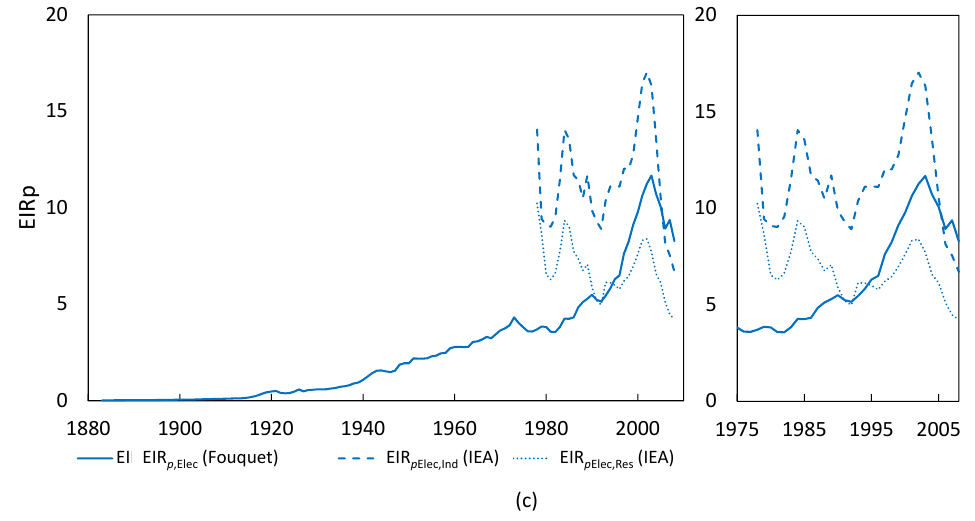
Figure 6. Energy intensity ratios for England and the United Kingdom for the following commodities: ( a ) wood and coal; ( b ) oil and natural gas; and ( c ) electricity. Calculations use three data sources for comparison: all nine energy commodity prices from the International Energy Agency (IEA) data (1978–2010), historical oil price from the BPStatistical Review (1861–2010) and historic firewood, coal, gas and electricity prices from Fouquet [54] (1300–2008). NG = natural gas, Elec = electricity, Ind = industrial and Res = residential. EIR p is the “EIR of the price of natural gas purchased by NG,Res the residential